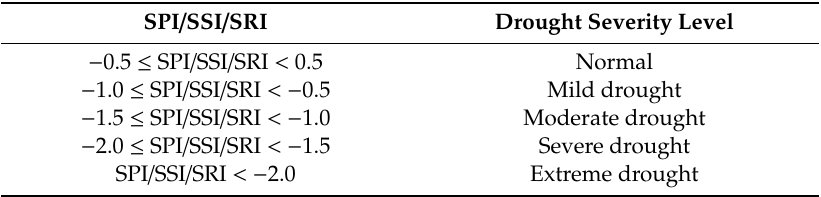
Table 2. The classification of the drought severity levels according to Standardized Precipitation Index (SPI), Standardized Soil Moisture Index (SSI), and Soil Runo ff Index